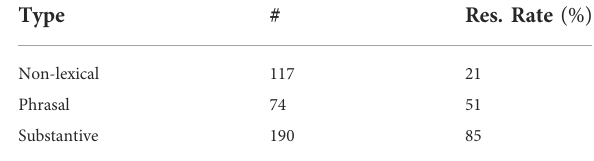
TABLE 4 Backchannel response